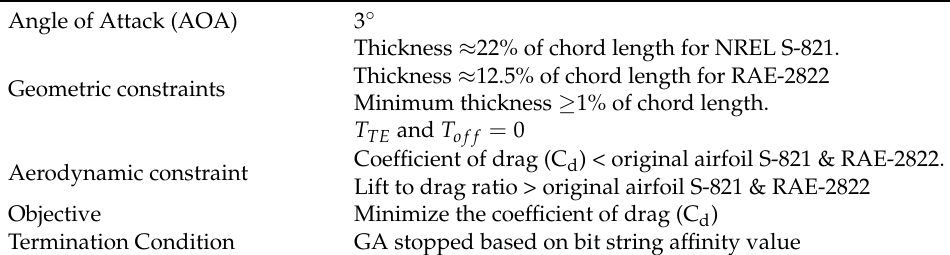
Table 3. Optimization objective and